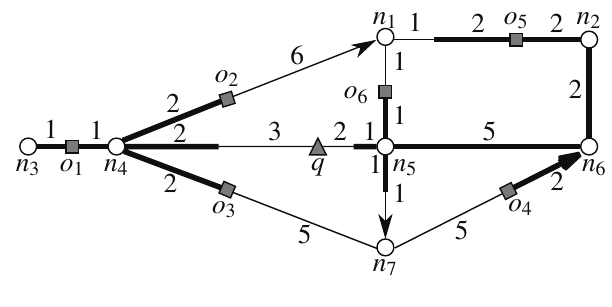
Fig. 9. Influence Region for o 4 and o 1